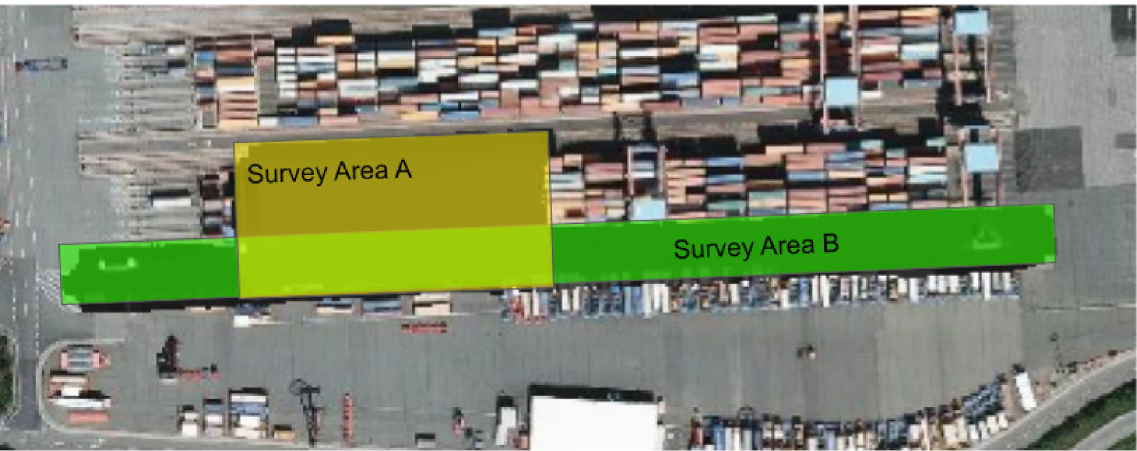
Figure 7. Measurement Area during CTA3 Campaign of Project AeroInspekt. The yellow marked survey area A was 100 m in length but contained the north and south side rails of both the cranes operating on this block. This area was chosen to carry out experiments with a different camera lens, sidelap, overlap, and flight